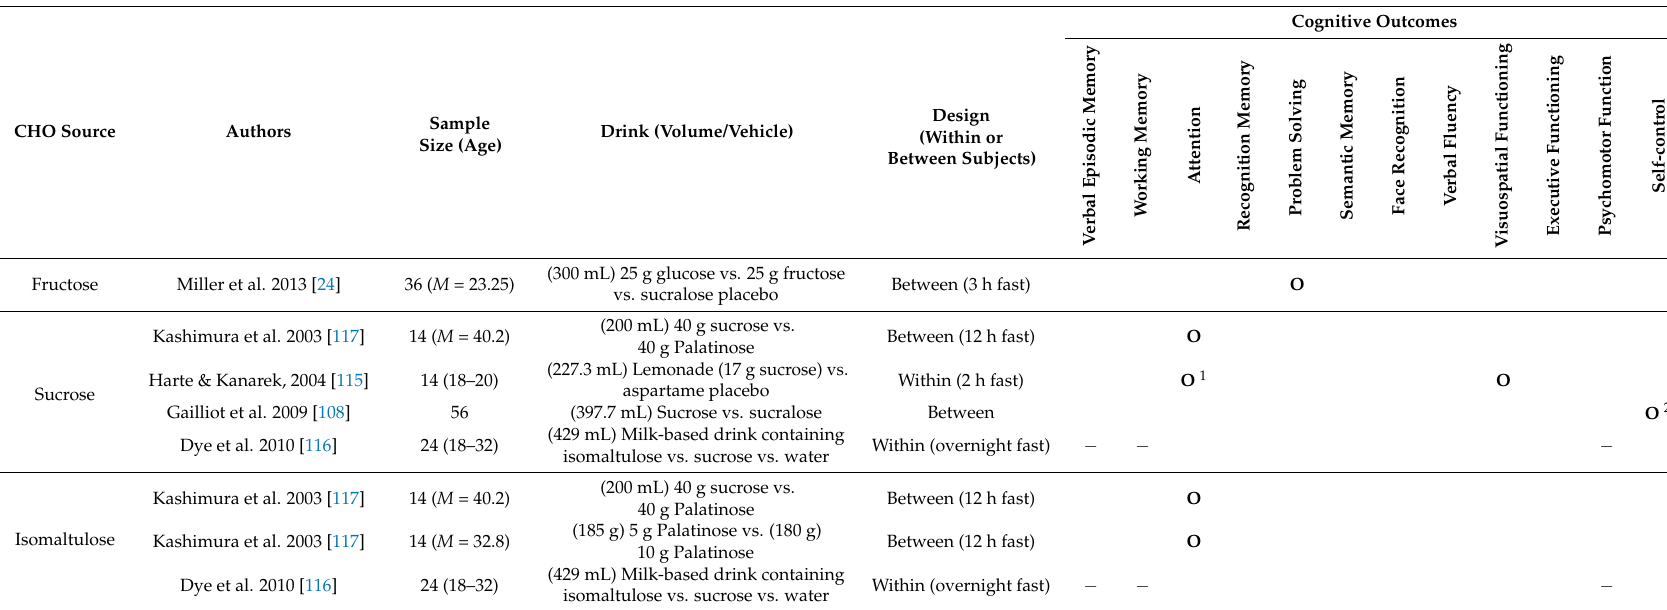
Table 3. Summary of studies examining the effects of fructose, sucrose and isomaltulose on cognitive performance